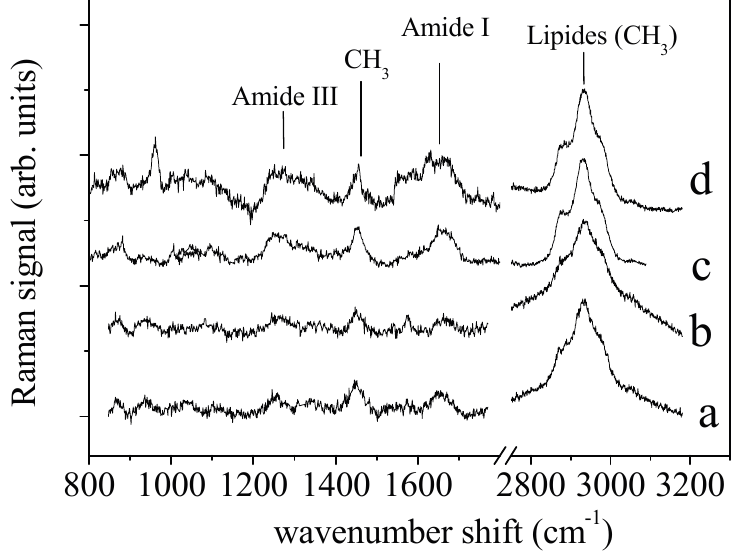
Figure 2. Periodontal ligament micro-Raman spectra for control sample ( a ); and